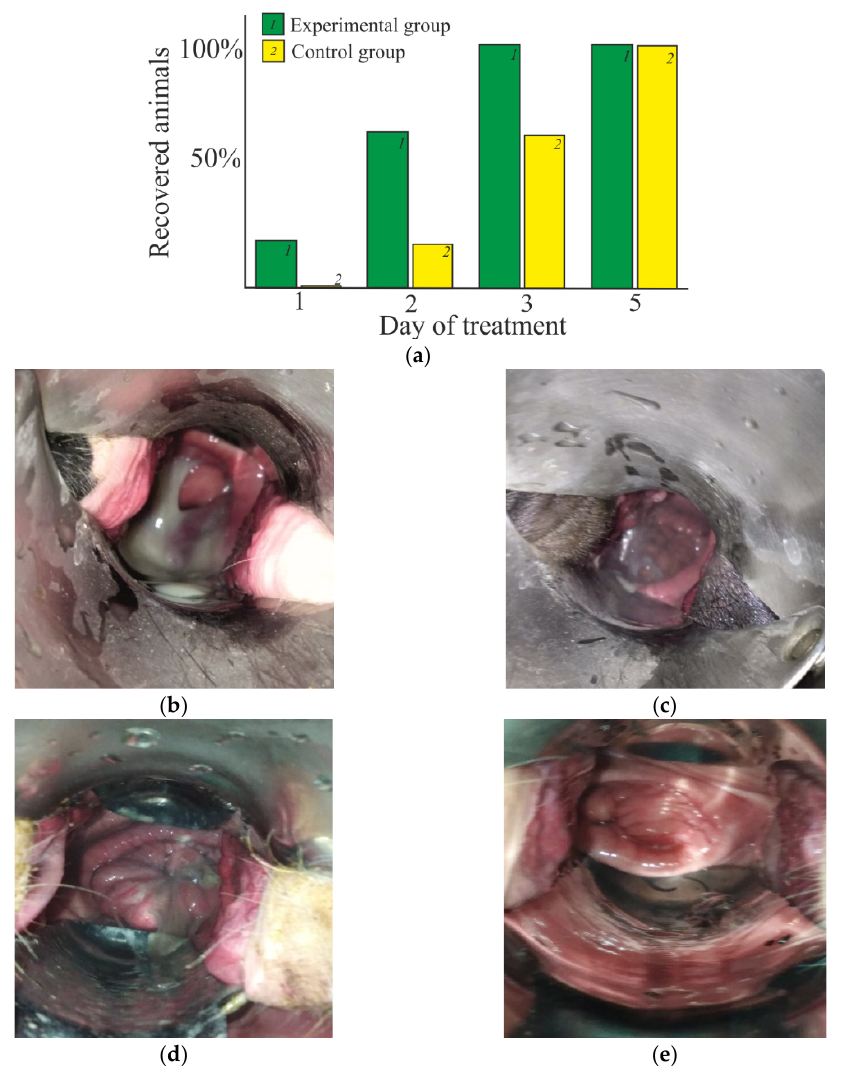
Figure 7. ( a ) Dynamics of the treatment of cows with postpartum serous-catarrhal vaginitis using our CS·HCl : Pl F-127 = 30:70 (vol./vol.) suppositories with С CS·HCl = 3 wt.%, С Pl F-127 = 25 wt.% and the addition of 3 wt.% D-AscA and Ichthyol IUDs (conventional therapy). ( b – e ) Clinical picture of traumatic postpartum vaginitis before ( b , d ) and after 3 days of the treatment with our suppositories ( c ), after 5 days of the treatment with Ichthyol IUDs ( e ).